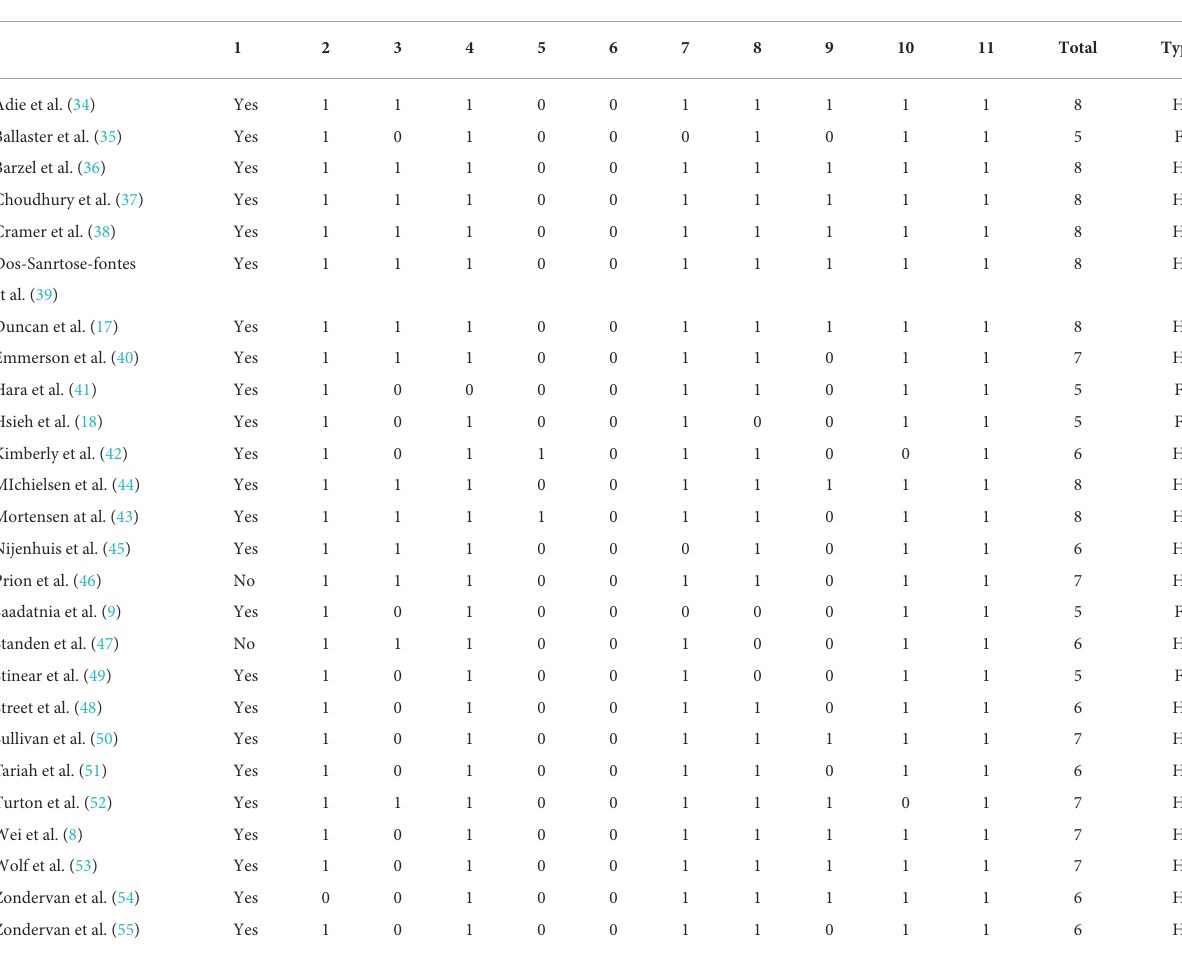
TABLE 2 Methodological quality of